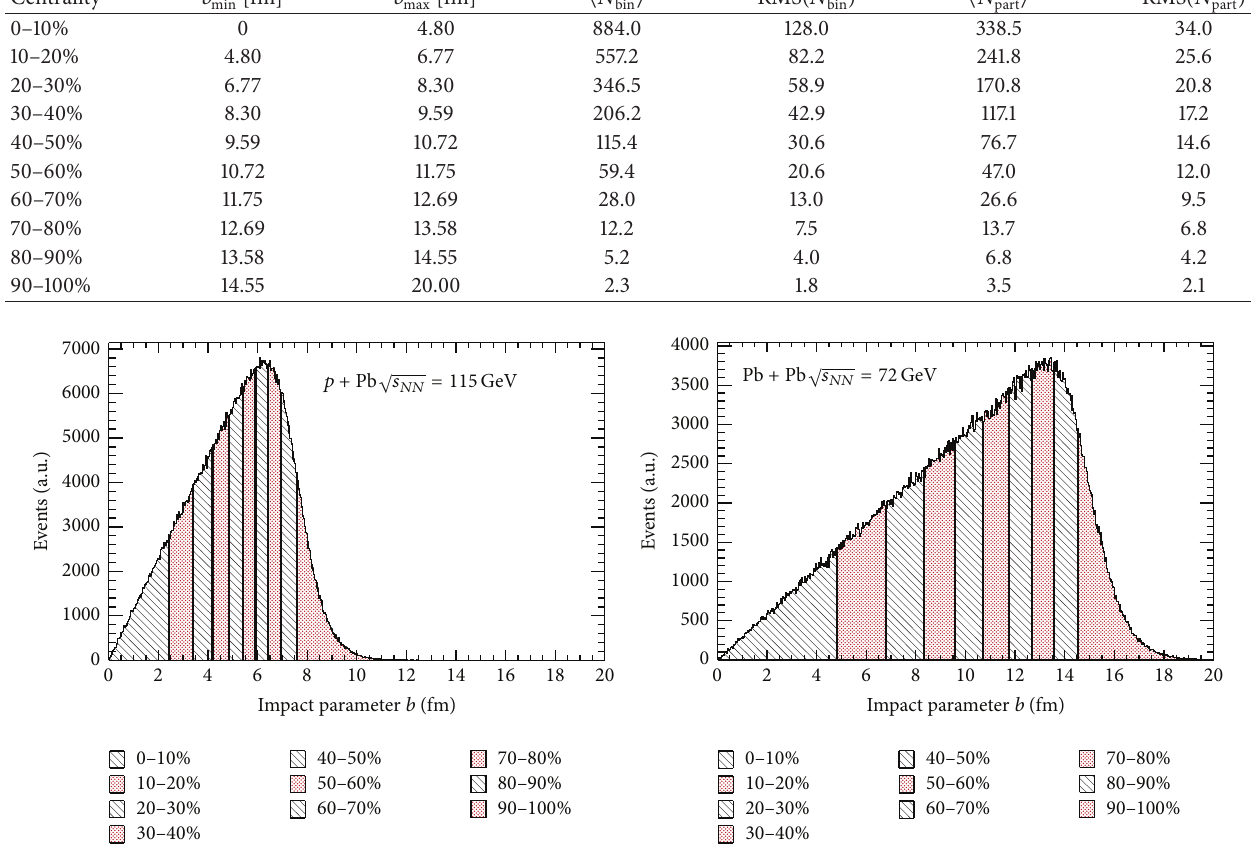
Table 2: Average number of participants ⟨𝑁 part ⟩ and binary collisions ⟨𝑁 bin ⟩ in Pb-Pb collisions at √𝑠 𝑁𝑁 = 72 GeV for centrality classes defined as percentiles of the hadronic cross section. The mean values and the RMS are obtained with a Glauber Monte Carlo calculation.